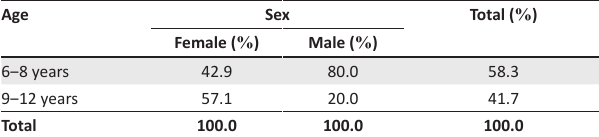
TABLE 2: Age and sex ( N =